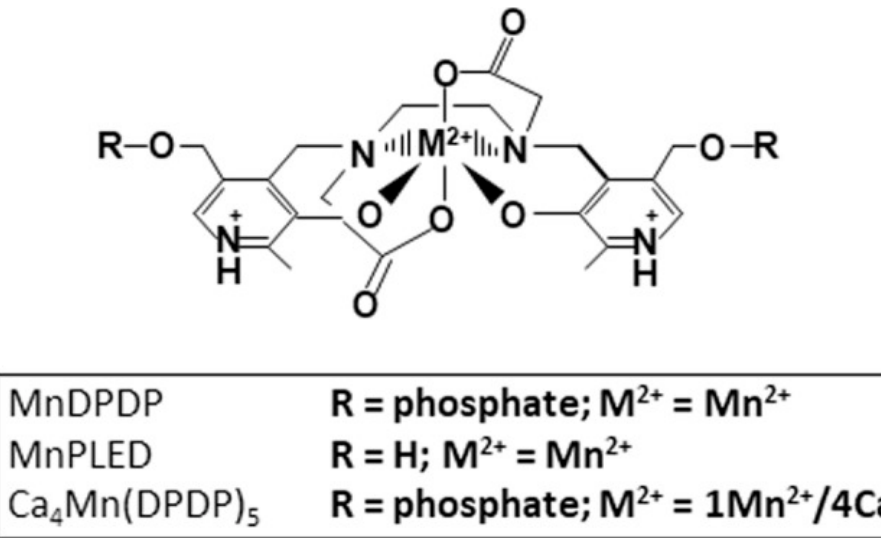
Figure 1. Chemical structure of MnDPDP (manganese dipyridoxyl diphosphate; generic name mangafodipir), MnPLED (manganese dipyridoxyl ethyldiamine), and Ca 4 Mn(DPDP) 5 [tetracalcium monomanganese penta(dipyridoxyl diphosphate); calmangafodipir].